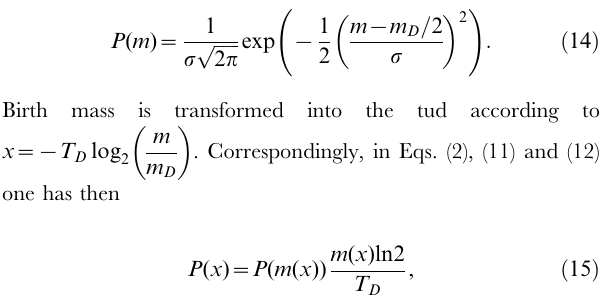
Figure S3 Stationary volume distributions. The volume histograms are shown for different strength of divisional noise: s ~ 0 : 2 (red), s ~ 0 : 1 (green), s ~ 0 : 05 (blue), s ~ 0 : 02 (magenta) and s ~ 0 (cyan).